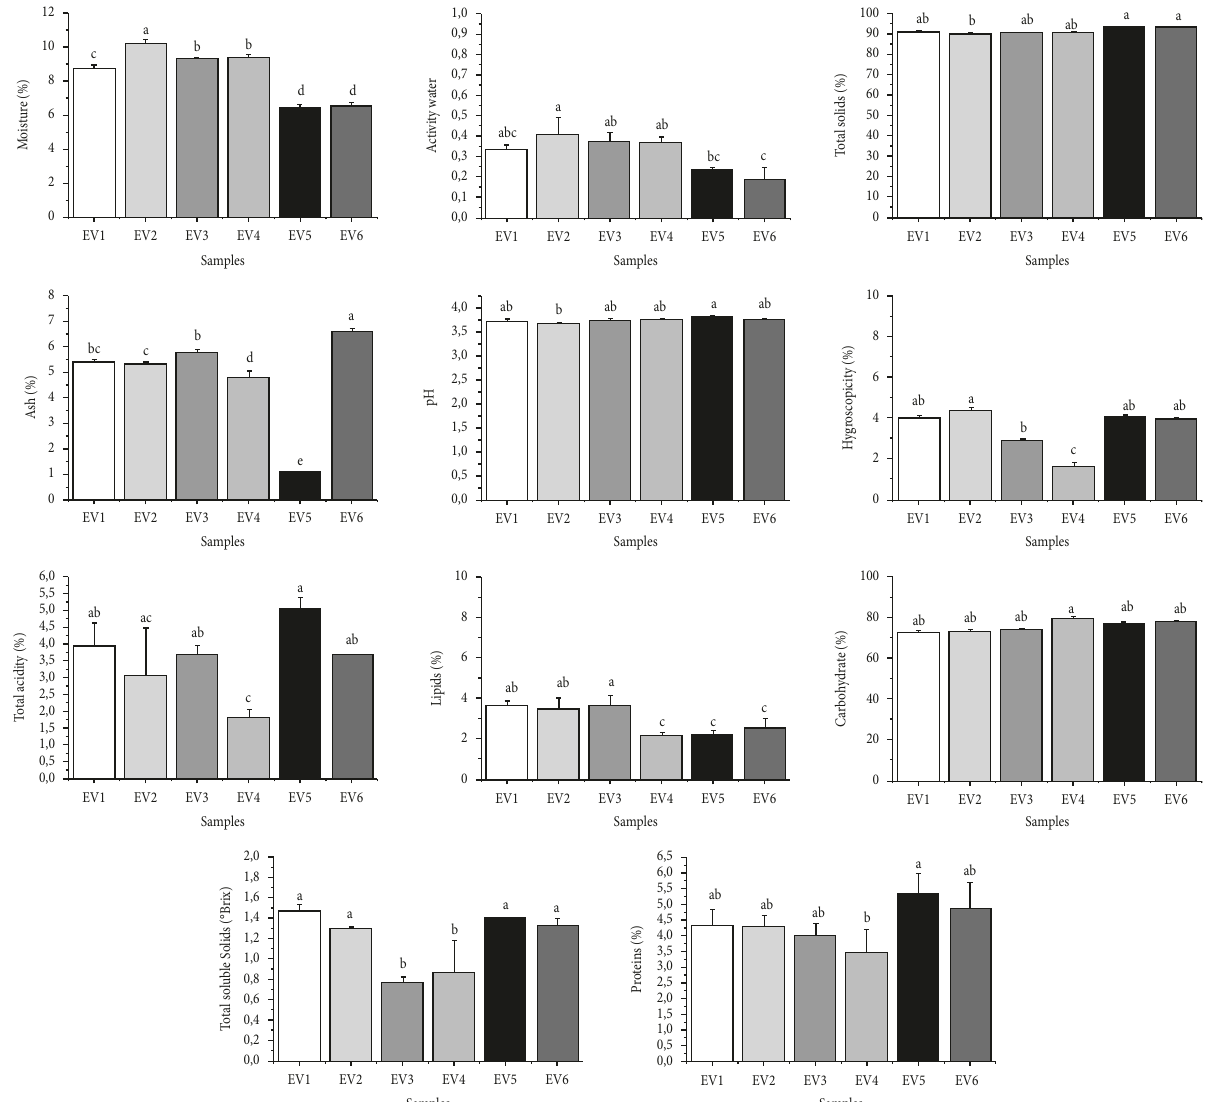
Figure 1: Centesimal composition of powdered compounds from Shiraz grape peels and arrowroot. Statistical analysis: values showing the same letter in the same analysis do not indicate significant differences ( p > 0 . 05) based on a Tukey test at a 95% confidence